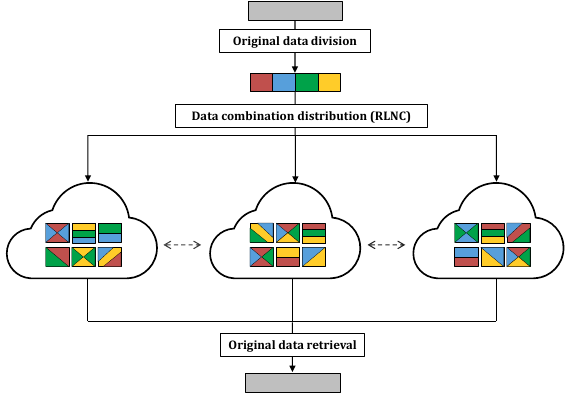
Figure 2. RLNC-based data combination distribution in a multi-cloud